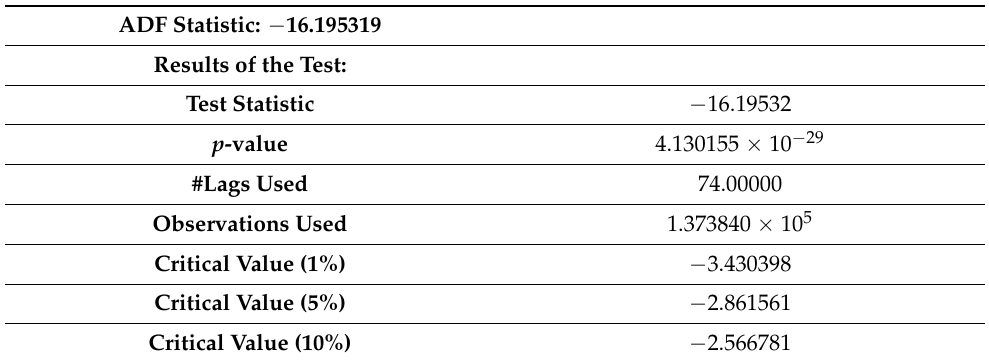
Table 1. Augmented Dickey Fuller (ADF) results to determine